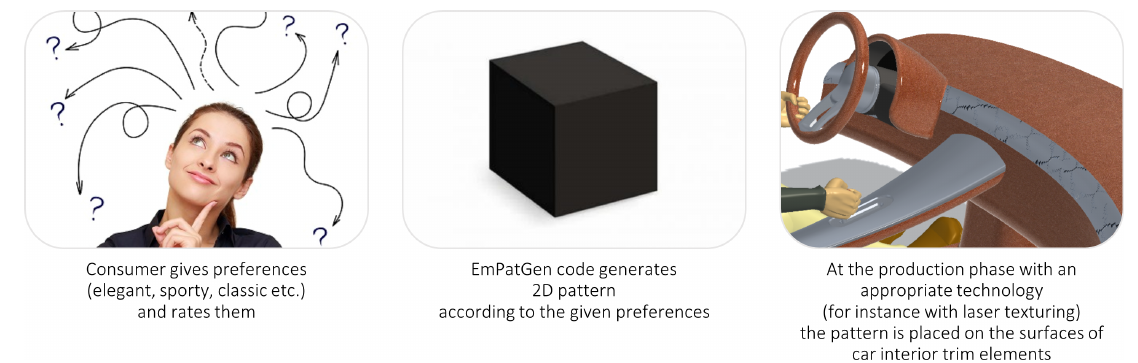
Figure 4. Steps of